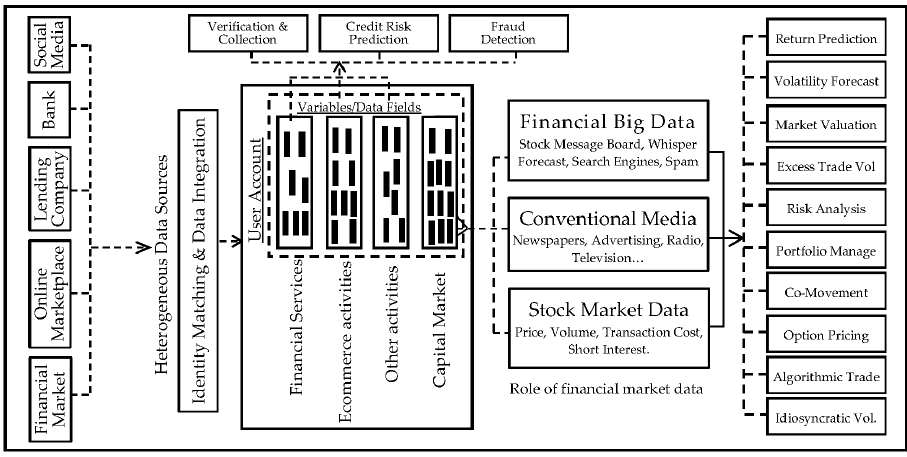
Figure 5. The framework of big data analytics in financial services, modified based on [54,58,62].